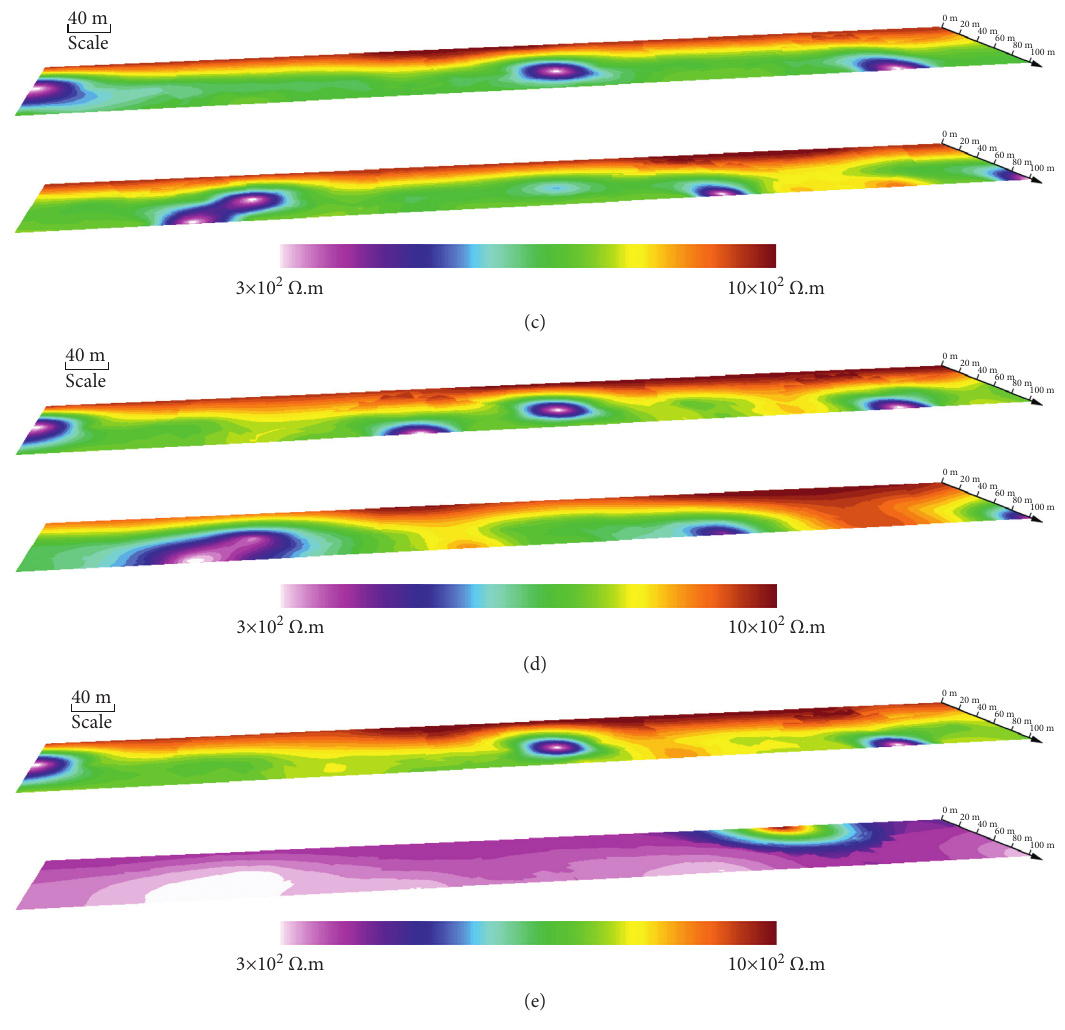
Figure 6: Apparent resistivity of aquifers after